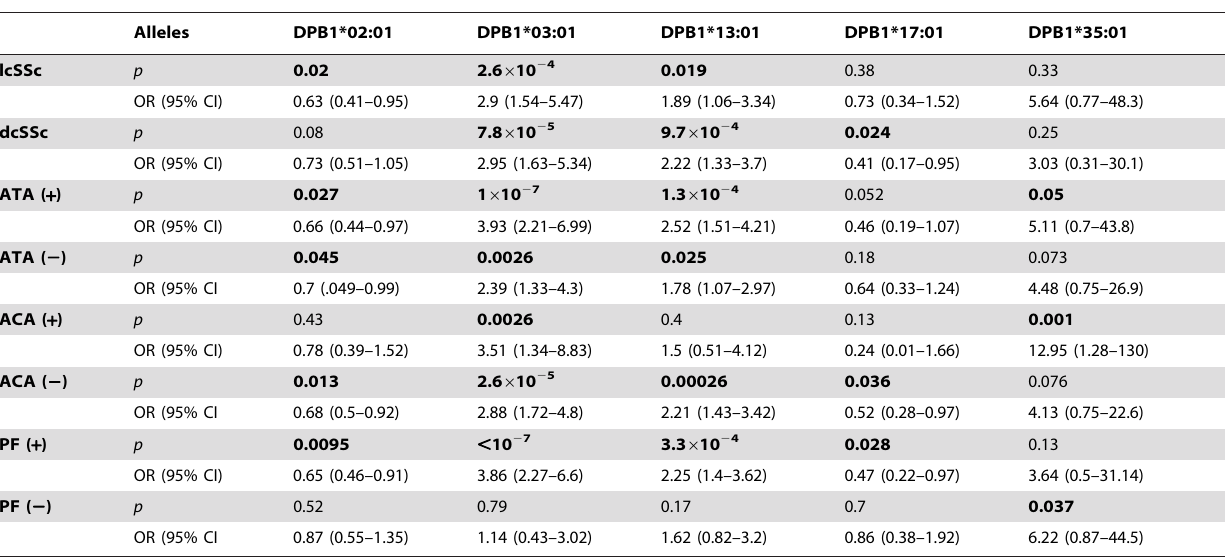
Table 2. Comparisons between controls and SSc subsets.